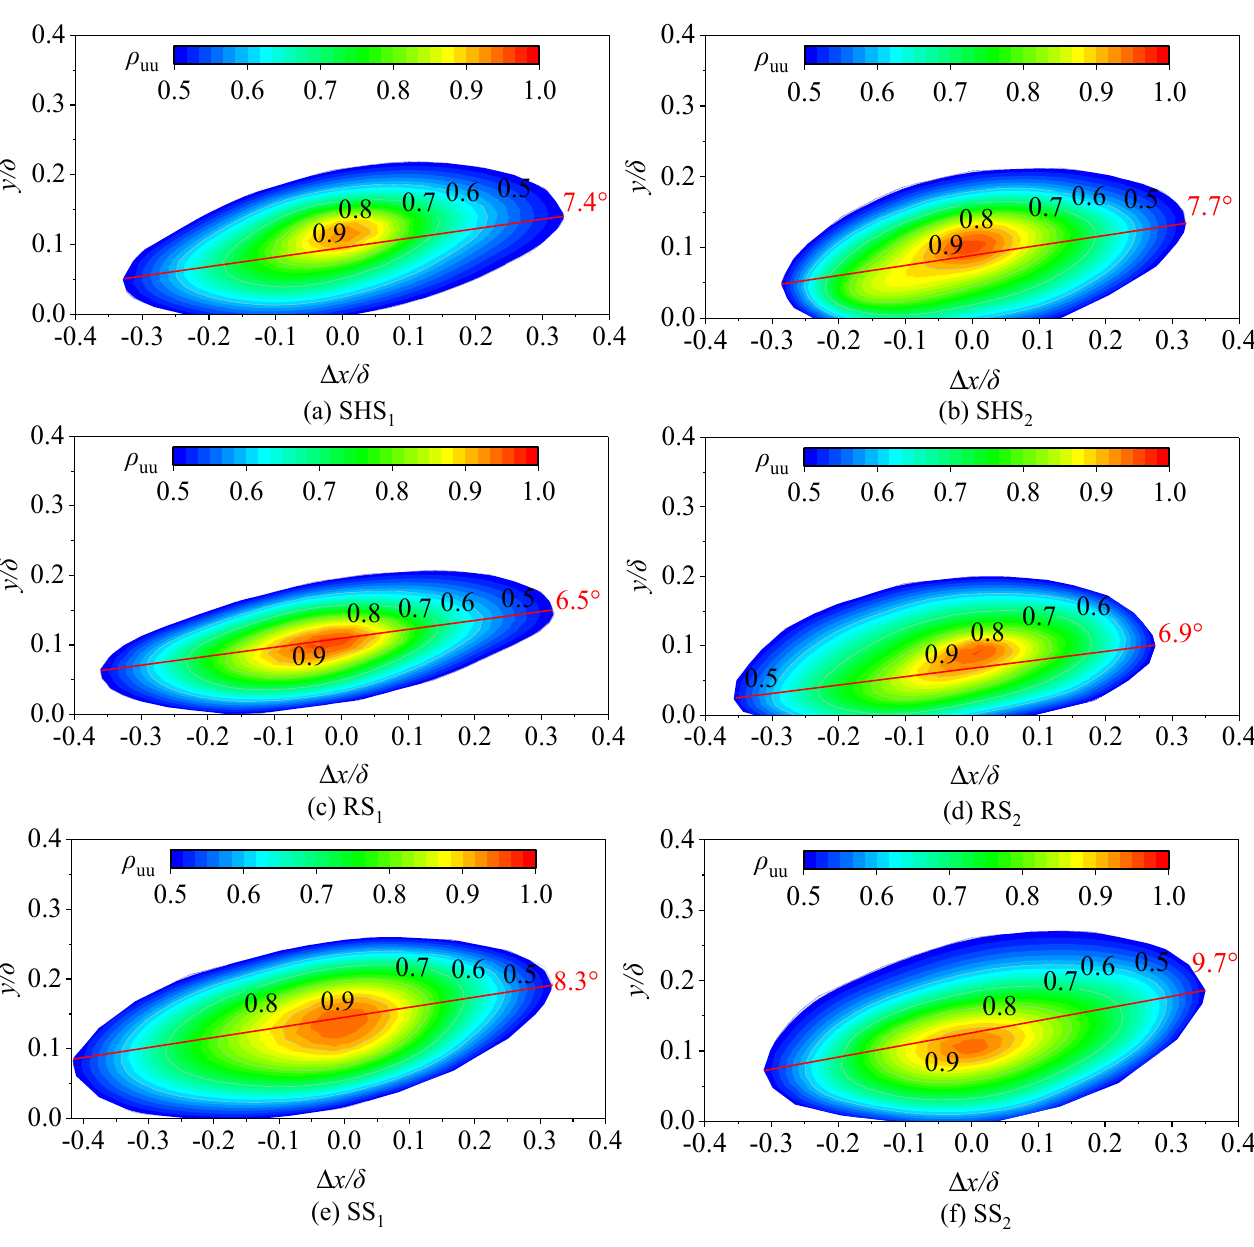
Figure 6. Spatial correlation analysis. Table 1. Characteristic parameters of spatial correlation analysis.